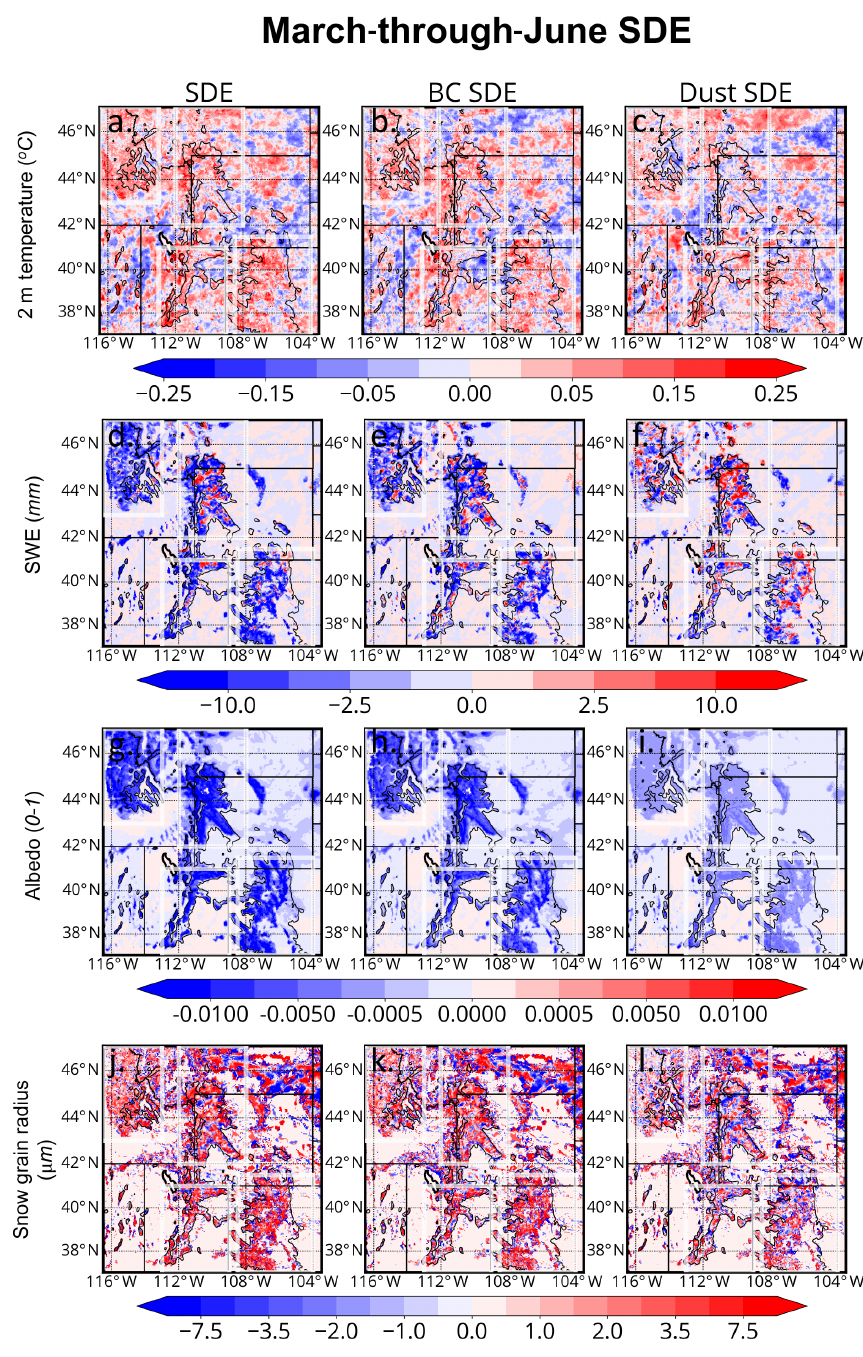
Figure 8. March-through-June-averaged SDE-induced anomalies in (top row) 2m temperature, (second row) SWE, (third row) albedo, and (bottom row) snow grain effective radius in the top snow level for (first column) BC + dust, (second column) BC, and (third column) dust. The thin black contours denote the 2200m elevation